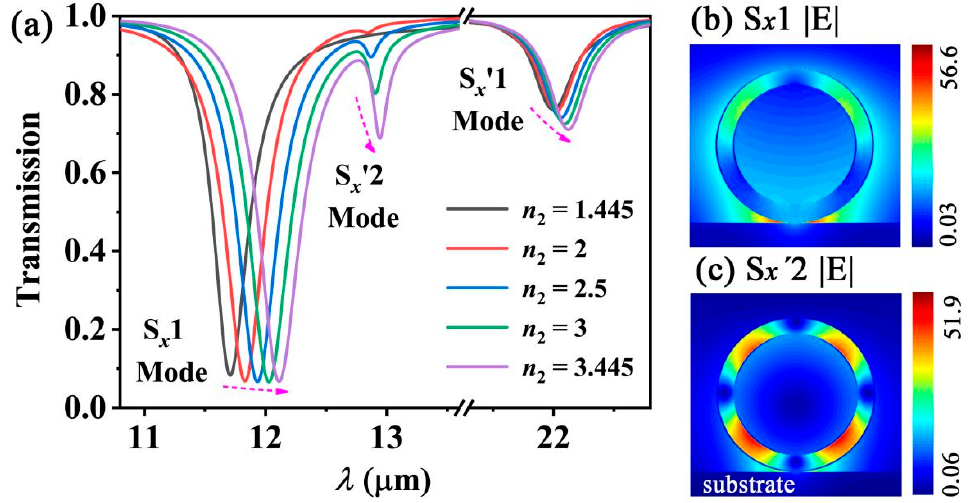
Figure 7. ( a ) Simulated transmission spectra with different n 2 . ( b , c ) show the | E | distribution of the S x 1 and S x ′ 2 modes, respectively.